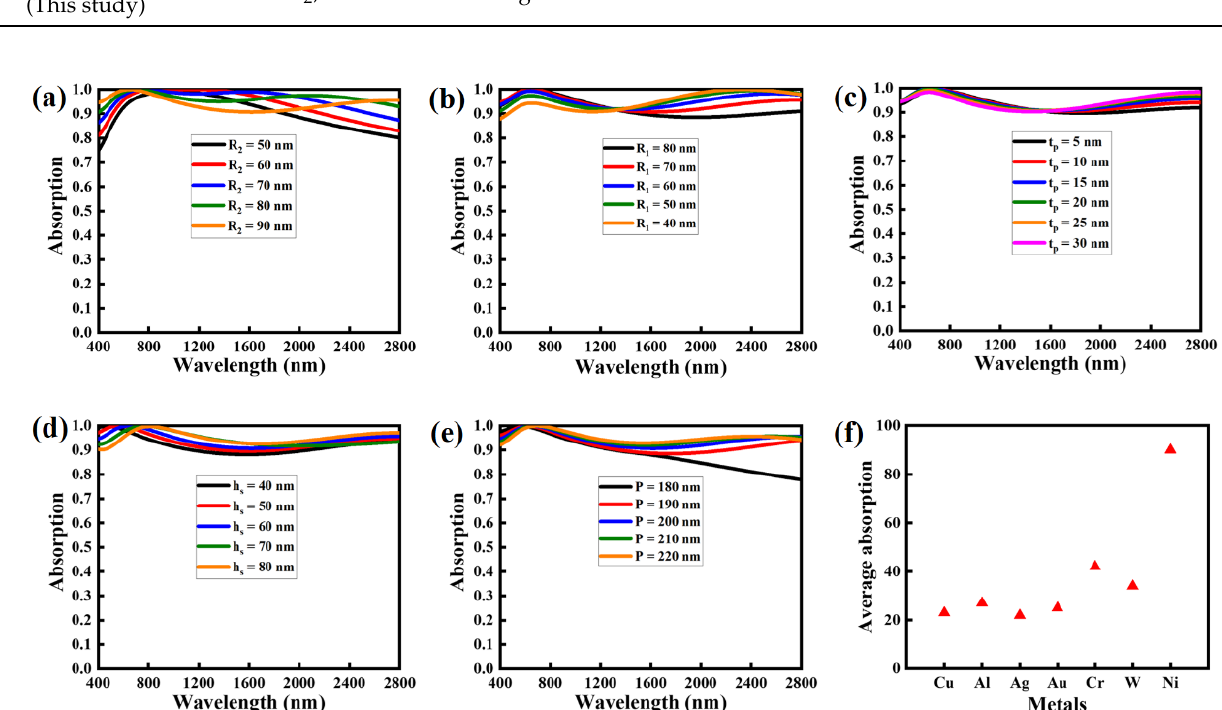
Figure 7. Optical absorption rate of the proposed NMMA under the variation of various geometric parameters: ( a ) outer radius of the top nano circular ring, ( b ) inner radius of the top nano circular ring, ( c ) thickness of the top nano circular ring, ( d ) thickness of the dielectric spacer, ( e ) periodicity of the unit cell, and ( f ) comparison of the average absorption rate of the different metals, which are used in designing the top nano circular ring.